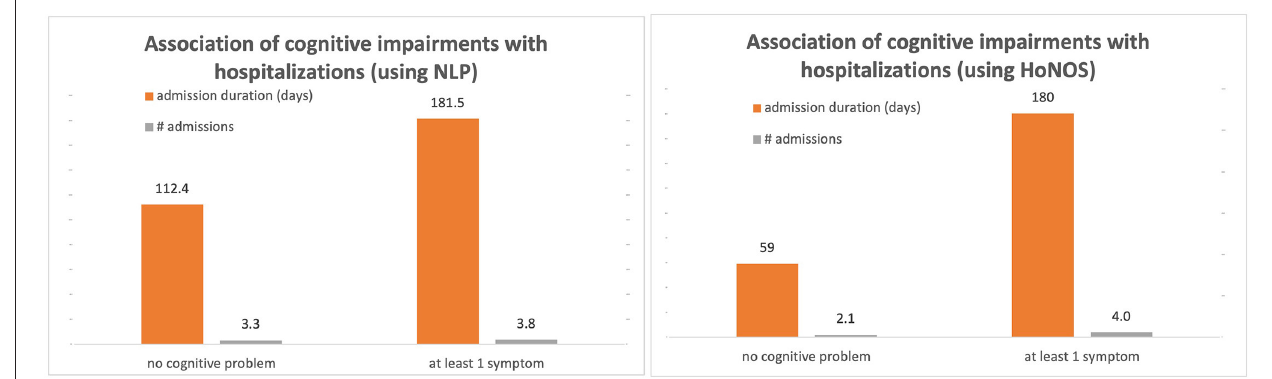
FIGURE 2 | Association of HoNOS and NLP scores with mental health